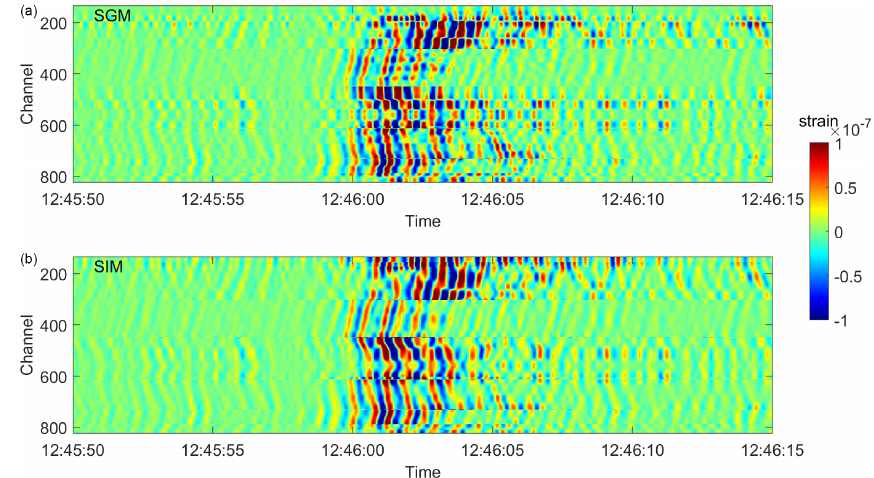
Figure 7. Strain estimates over all fibre channels using SGM (a) and SIM (b) for the VE event. The solutions with the minimum RMSE are chosen, respectively (Fig. 5).